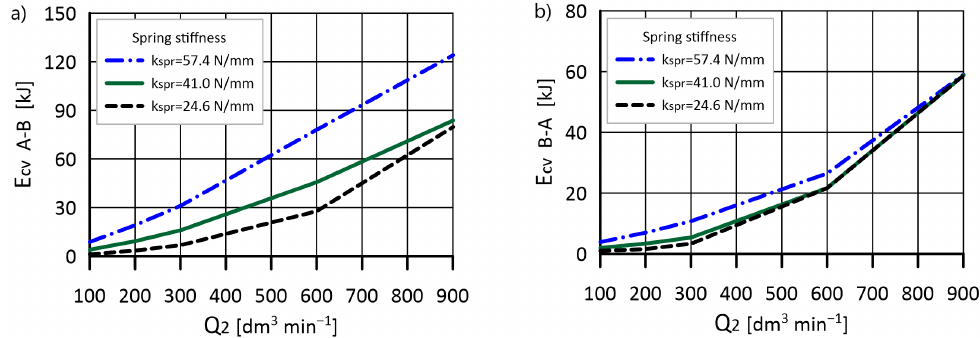
Figure 19. Energy consumption of the valve during the working cycle, flow direction: ( a ) A-B, ( b ) B-A.